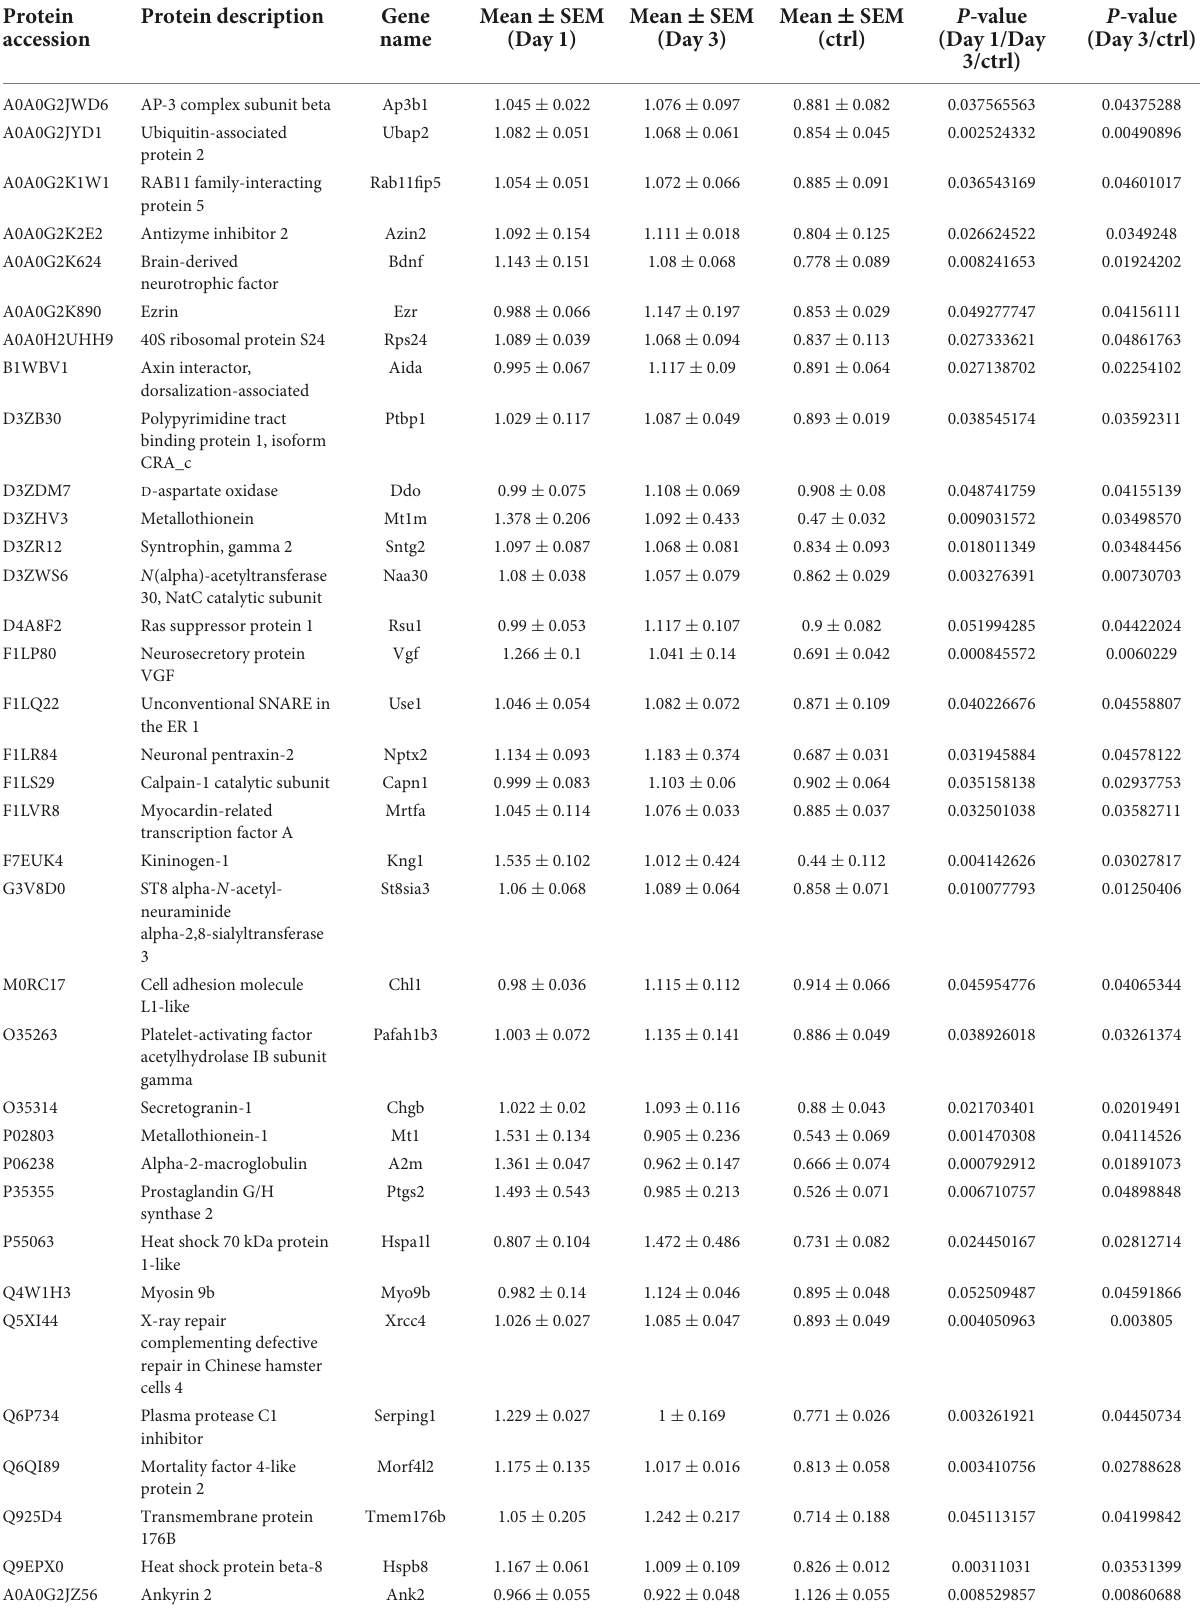
TABLE 2 Differentially expression proteins on Day 3 comparing with control (ctrl) in hippocampus post ANOVA analysis. Protein Protein accession